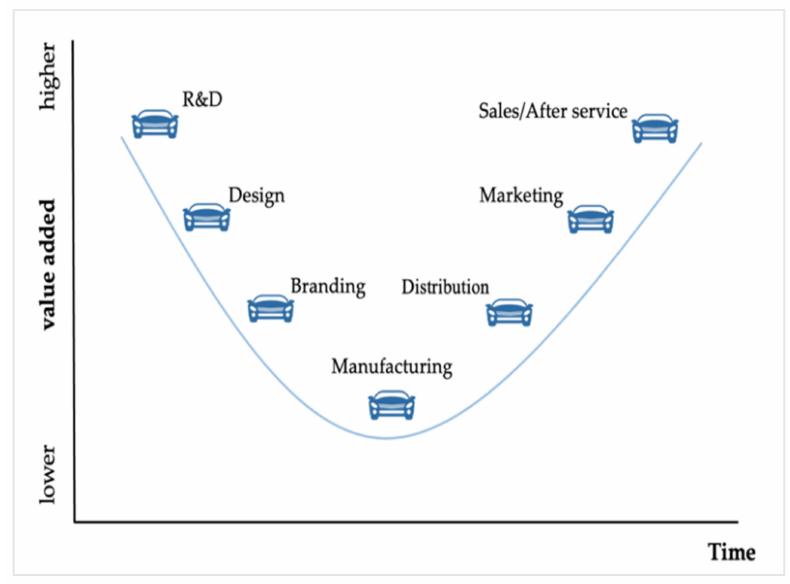
Figure 1. Value-added in global value chain (individual processes). Source: Authors’